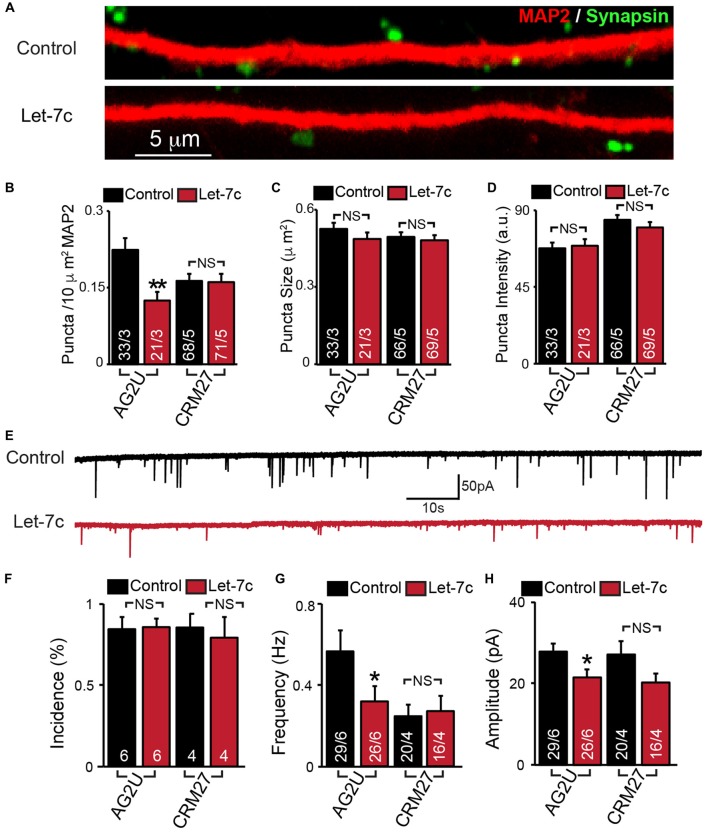
Hsa-let-7c overexpression alters synaptic transmission in human iN cells. (A–D) let-7c overexpression significantly reduced the density but not size or fluorescence intensity of synapsin+ puncta in AG2U iPS-derived induced neurons. (E) Representative traces of spontaneous excitatory post-synaptic currents (sEPSCs) in control and let-7c infected iN cells. (F) Overexpression of let-7c does not decrease the incidence of sEPSCs in either cell line. (G) let-7c overexpression results in a significant decrease in sEPSC frequency in AG2U iPS-derived induced neurons. (H) The amplitude of sEPScs is significantly decreased by let-7c overexpression in the AG2U cell line. Statistical tests were performed using two-tailed Student’s t-test, where *p < 0.05, **p < 0.01.